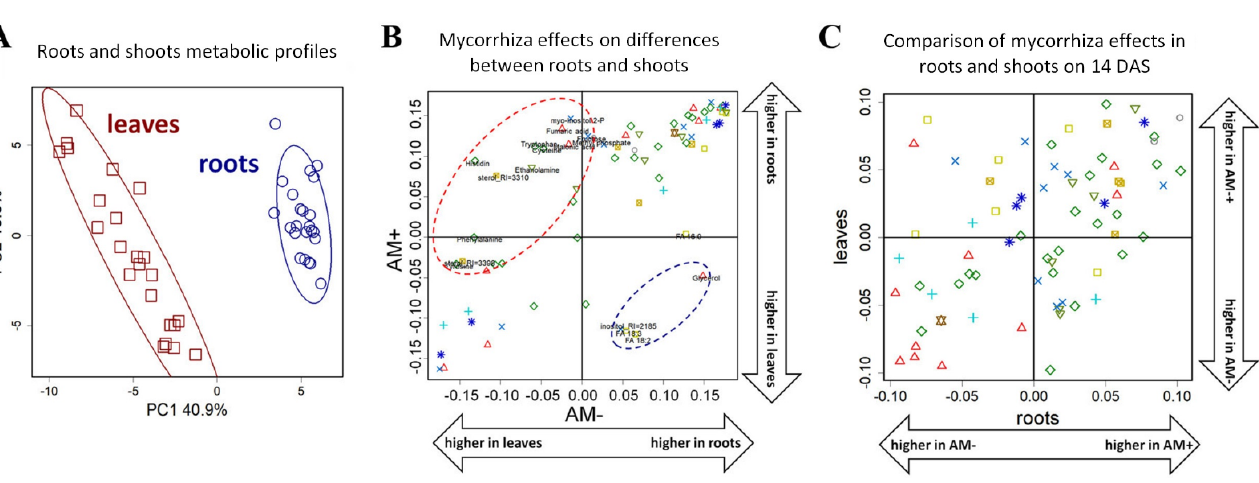
Figure 7. Organ specificity and mycorrhiza effects. Score plot from PCA for metabolites identified in leaves and roots profiles ( A ). SUS plot in the space of loadings from two OPLS-DA models for discrimination of roots and leaves in AM+ and AM − plants ( B ). SUS plot in the space of the loadings from two OPLS-DA models for discrimination of AM+ and AM − roots (abscissa) and shoots (ordinate) of plants at 14 DAS ( C ). Symbols for carboxylates and alcohols, amino acids, N-compounds, pentoses, hexoses, «complex sugars», secondary metabolites, fatty acids, sterols and terpenes, not identified compounds are the same as in Figure 6.